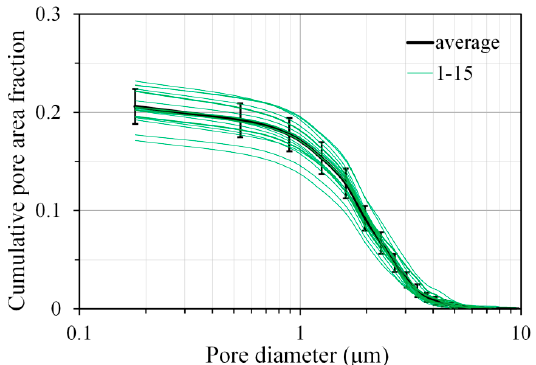
Figure 4. Calculated pore size distribution of samples for AAS4 at curing age of 1 day (AAS indicates alkali-activated slag, the number following AAS refers to the weight percentage of Na 2 O with respect to slag. The water to slag ratio was 0.4 and the curing temperature was 20 °C).